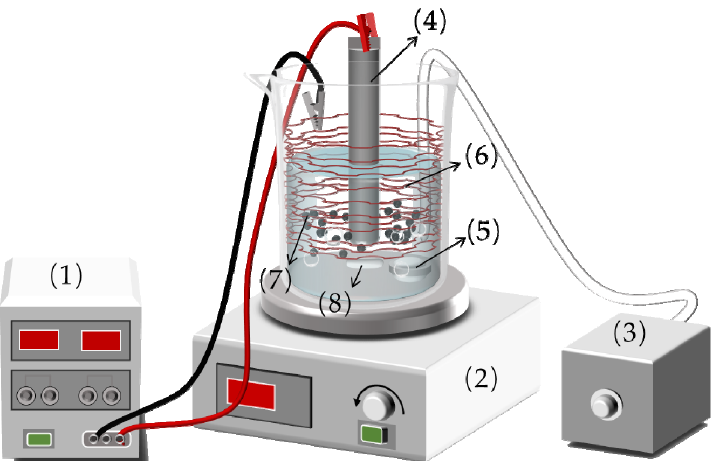
Figure 1. Schematic diagram of the reaction device: (1) DC regulated power supply; (2) magnetic stirrer; (3) air pump; (4) graphite rod; (5) aeration stone; (6) Cu-SSE; (7) NZVIs-BC; (8) magnetic rotor. The initial concentration of 2-naphthol was about 10.0 mg L − 1 . Sulfuric acid (1.0 mol L − 1 ) and sodium hydroxide solution (1.0 mol L − 1 ) was used to adjust the initial pH value of 2-naphthol